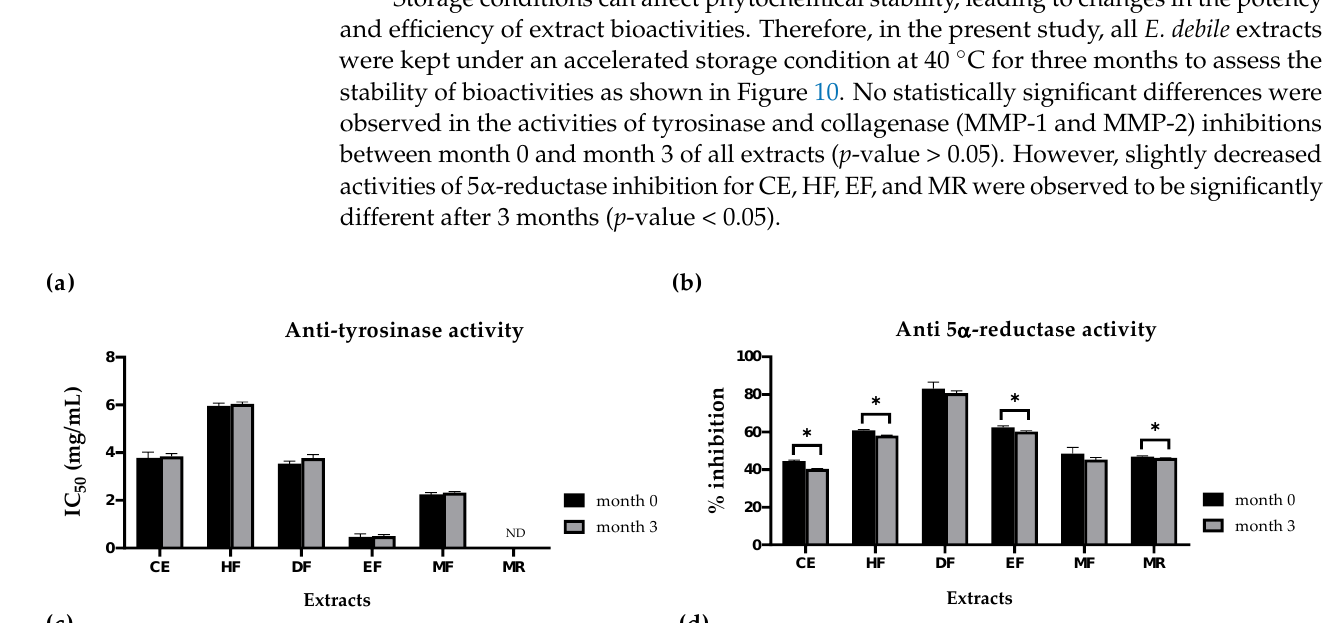
a c c Figure 9. Anti- 5α -reductase activities of E. debile extracts. i – v Successive partition of crude extract (CE) (10.45 ± 1.20 g) into hexane fraction (HF), dichloromethane fraction (DF), ethyl acetate fraction (EF), methanol fraction (MF), and methanol insoluble residue (MR). All data are presented as mean